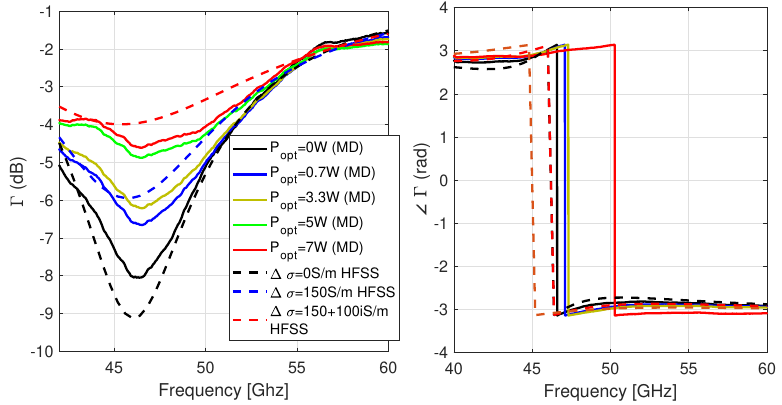
Figure 8. Measured (MD) and Simulated (SD) magnitude Γ ( dB ) and phase ∠ Γ ( rad ) values of reflection coefficient under different optical illumination power from FSS structures on HR Silicon substrate with a thickness of 250 µ